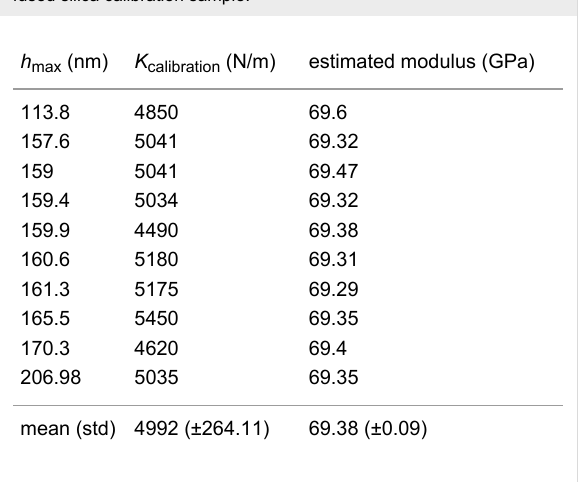
Table 1: Experimental data obtained during calibration of k fork on the fused silica calibration